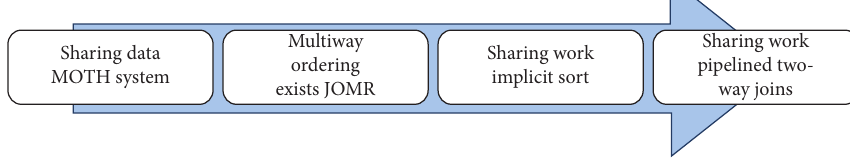
Figure 7: Optimization stages of J-MOTH multiway join optimizer.